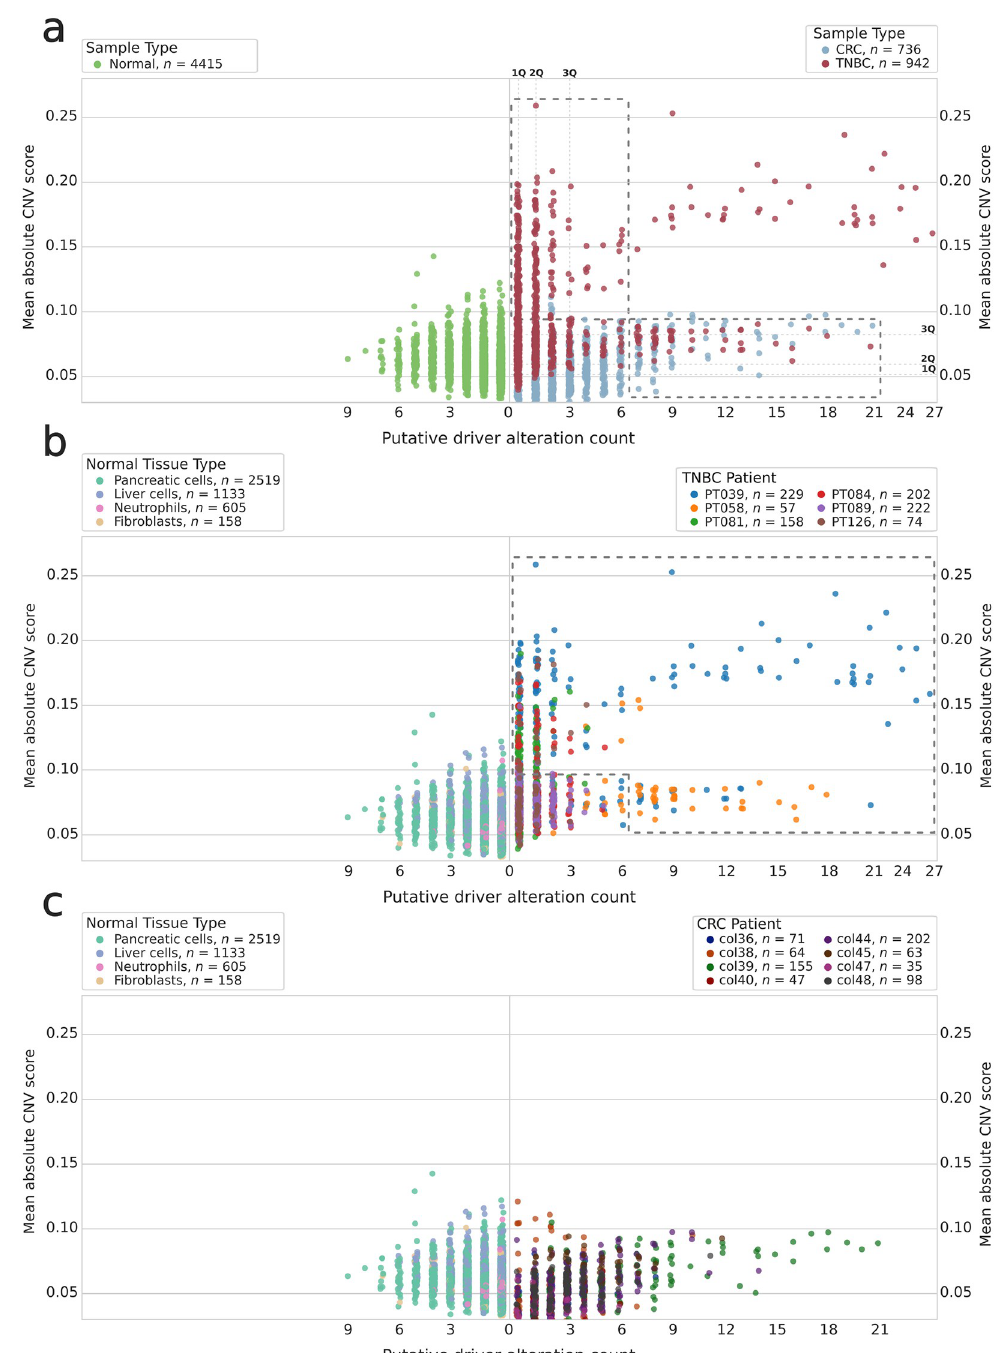
Fig 3. Relationship between putative driver alteration counts and inferred CNV for normal tissues (left) and tumor (right) dataset cells. (A) Cancer dataset (at right) cells shown based on primary tumor site, normal cells shown together at left. (B) TNBC cells, grouped by patient, shown in comparison to normal cells, grouped by tissue type. (C) CRC cells, grouped by patient, shown in comparison to normal cells, grouped by tissue type. Higher mean absolute CNV values indicate predicted structural alterations resulting in copy number variation, and lower values suggest limited CNV. Dashed rectangles in (A) indicate regions of interest: groups of cells that might be identified as cancer cells by either CNV inference or putative driver alteration count. Dashed rectangles are bounded at the lower ends by the 99th percentile values derived from the values for 4,415 normal cells amenable to both CopyKAT and variant analysis. Dashed polygon in (B) indicates cells of interest, with either high CNV scores or high putative driver counts, that might be selected for downstream analyses. In (A), first, second, and third quartiles are indicated for tumor cells by dashed lines and bold labels along their respective